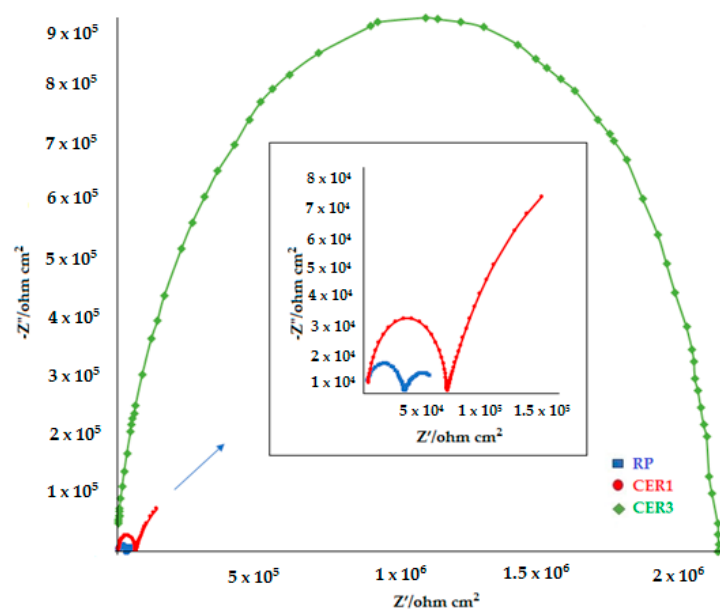
Figure 6. Nyquist diagrams of RP, CER1 and CER3 after immersion in 3.5% NaCl solution for 4 days.